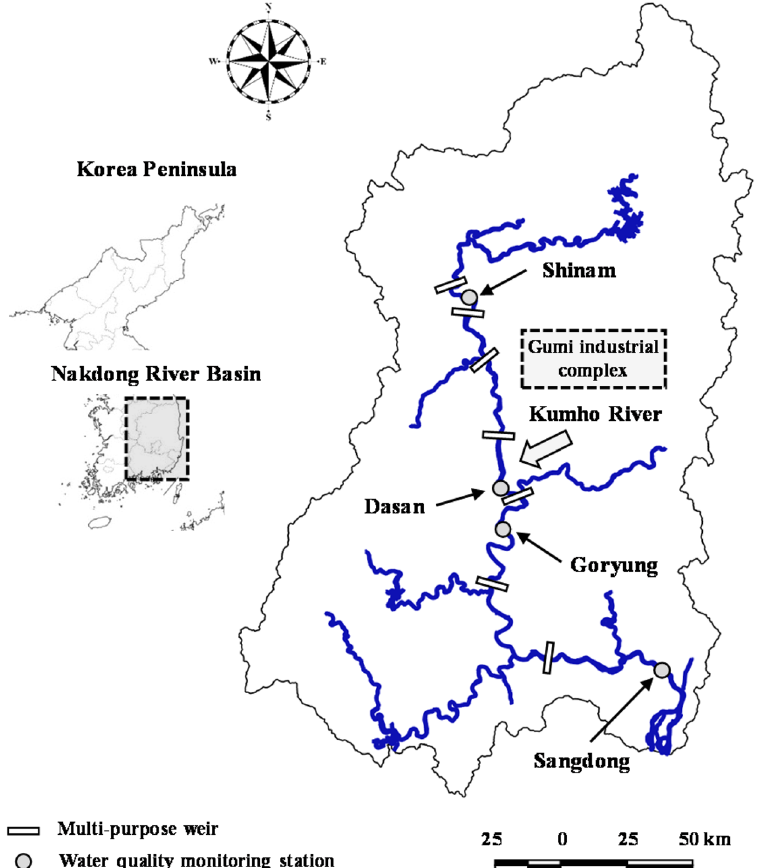
Figure 1. Location of target water quality monitoring stations in the Nakdong River.